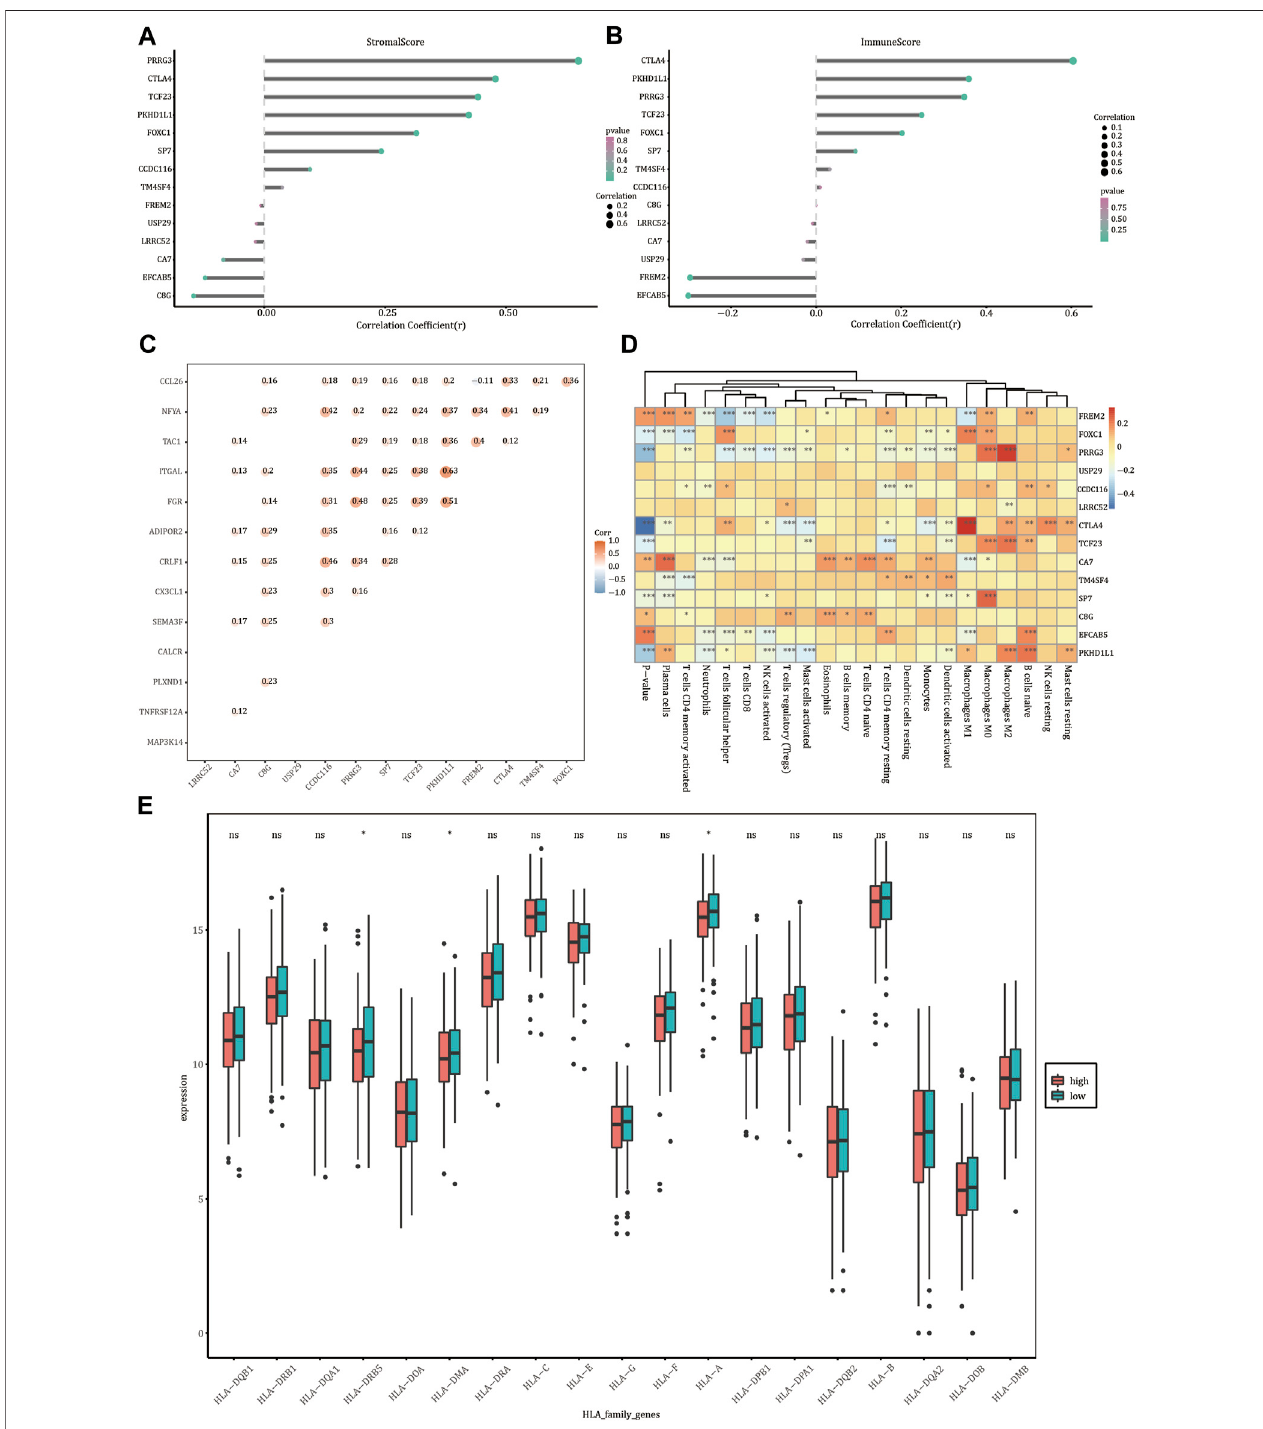
FIGURE 8 | Immune correlation analysis. Correlation of the expression levels of FREM2 and characteristic genes with the stromal cells (A) and the abundance of immune cells (B) . (C) Correlation between FREM2 and characteristic genes and immune genes. (D) Correlation between FREM2 and characteristic gene expression levels and immune cell in fi ltration. (E) Correlation between members of the HLA family expression levels and risk score.